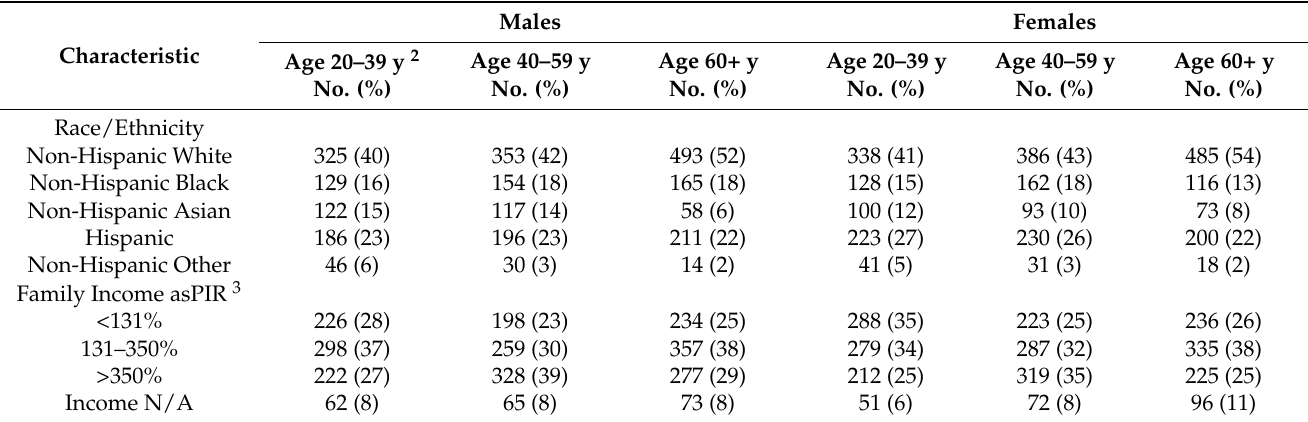
Table 1. Sociodemographic characteristics of U.S. adults by sex and age, What We Eat in America, National Health and Nutrition Examination Survey (WWEIA, NHANES) 2013–2016 1